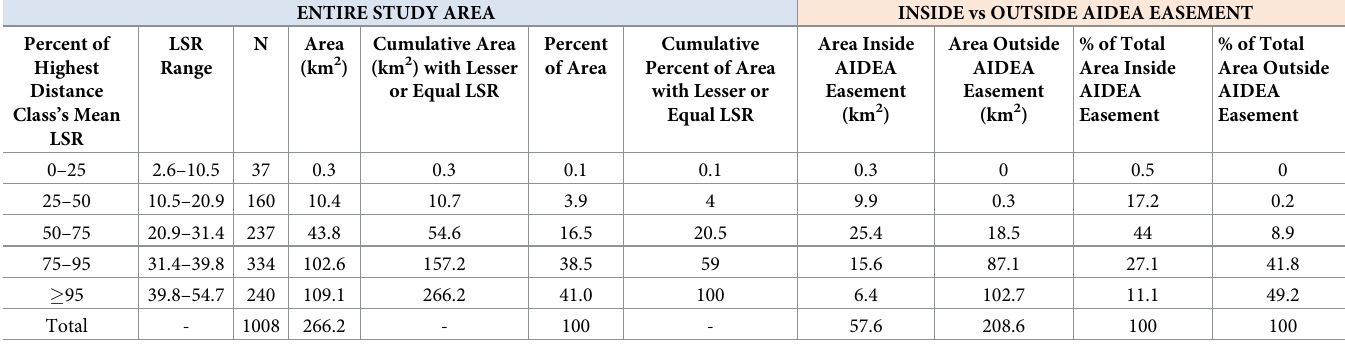
Table 6. Area estimates in CAKR by percentage of the mean LSR of the 3000–4000 m distance class (41.9) according to the posterior predictions model. The areas represented here are only those within the study area (i.e., within a 4000 m buffer of the DMTS haul road and on NPS lands). ENTIRE STUDY AREA INSIDE vs OUTSIDE AIDEA EASEMENT Percent of